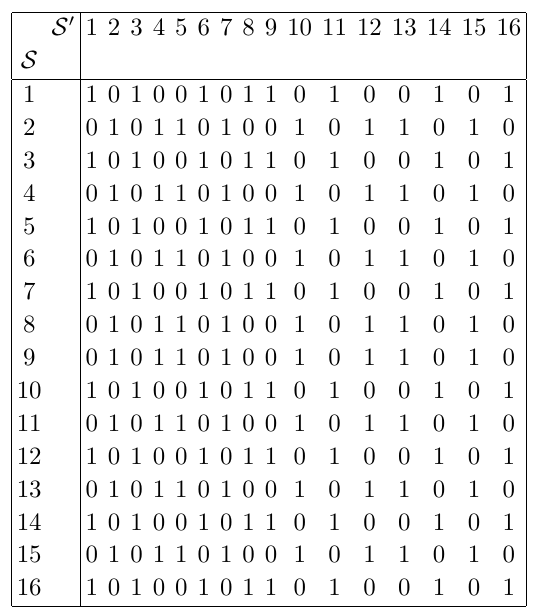
Table 20 . Gadget values for P